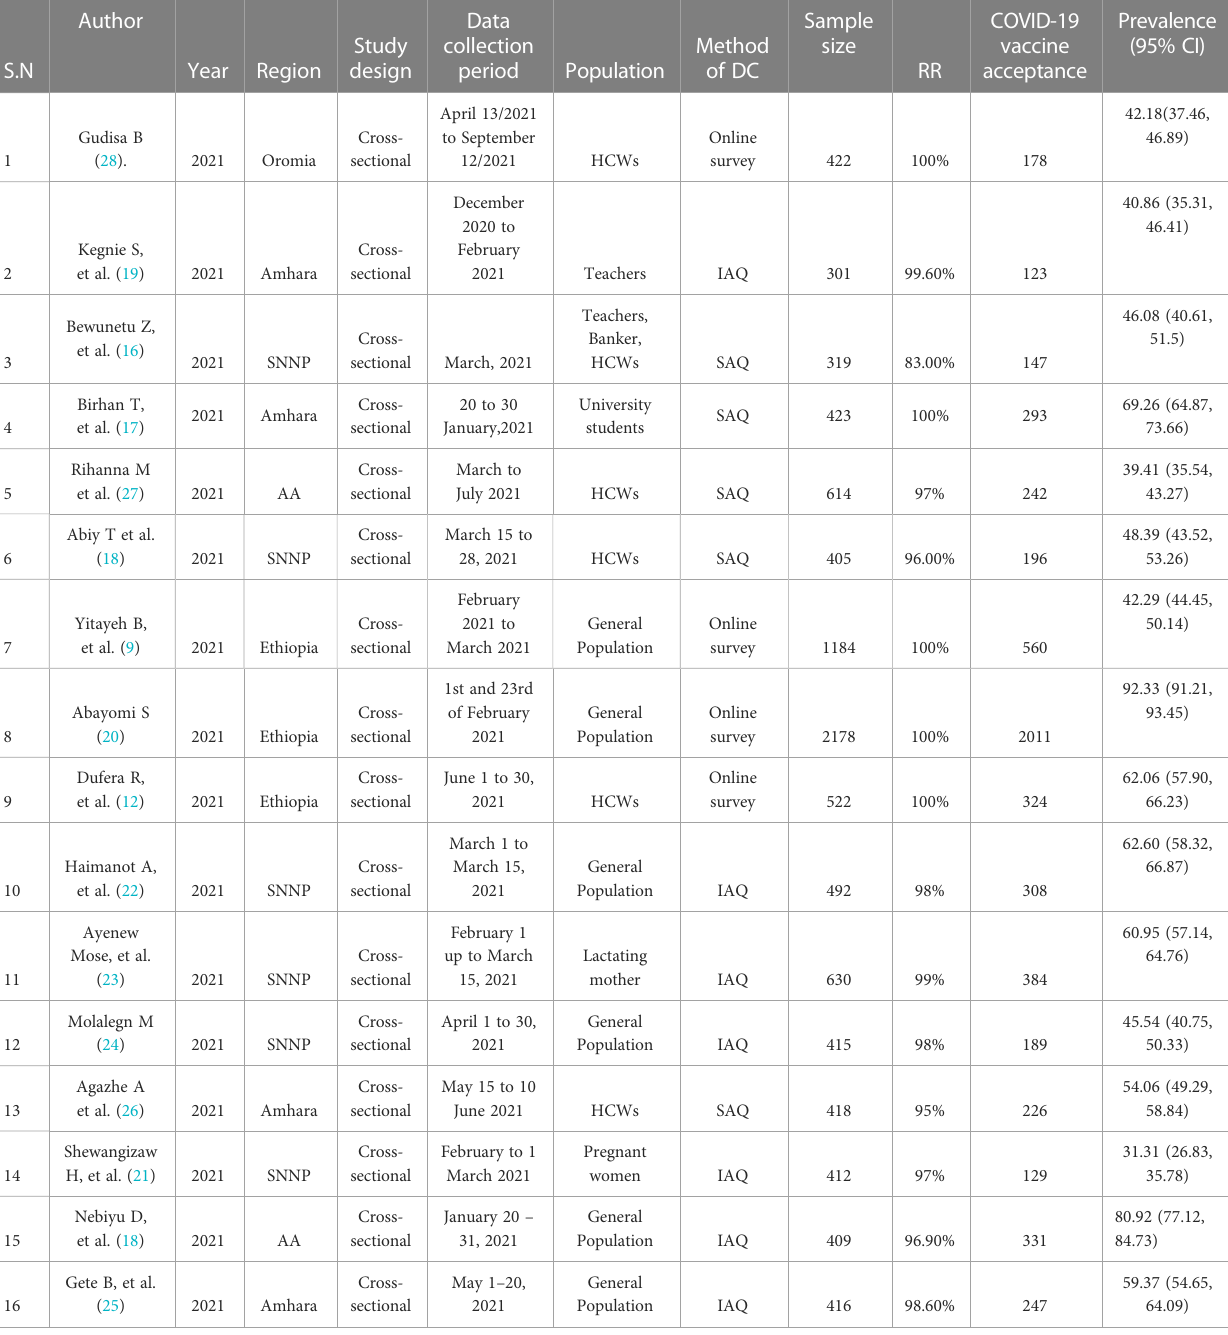
TABLE 1 Summary of Included Studies regarding willingness to accept COVID-19 vaccine in Ethiopia, 2022Willingness to accept COVID-19 vaccine.